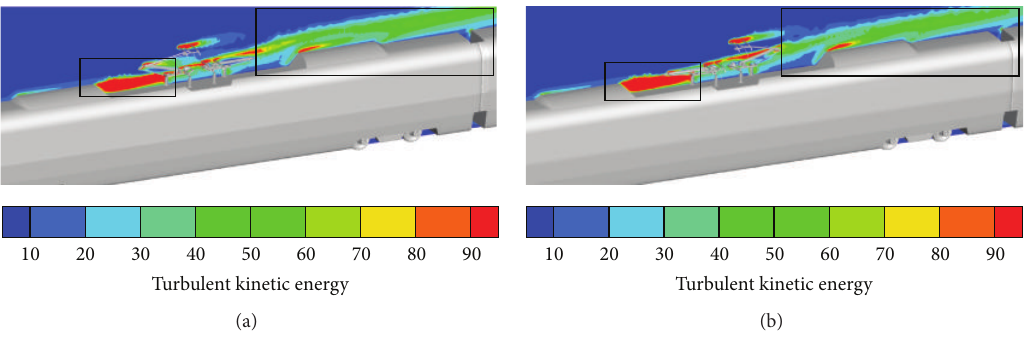
Figure 27: TKE distributions for different pantograph lifting configurations ((a): Sg1; (b):